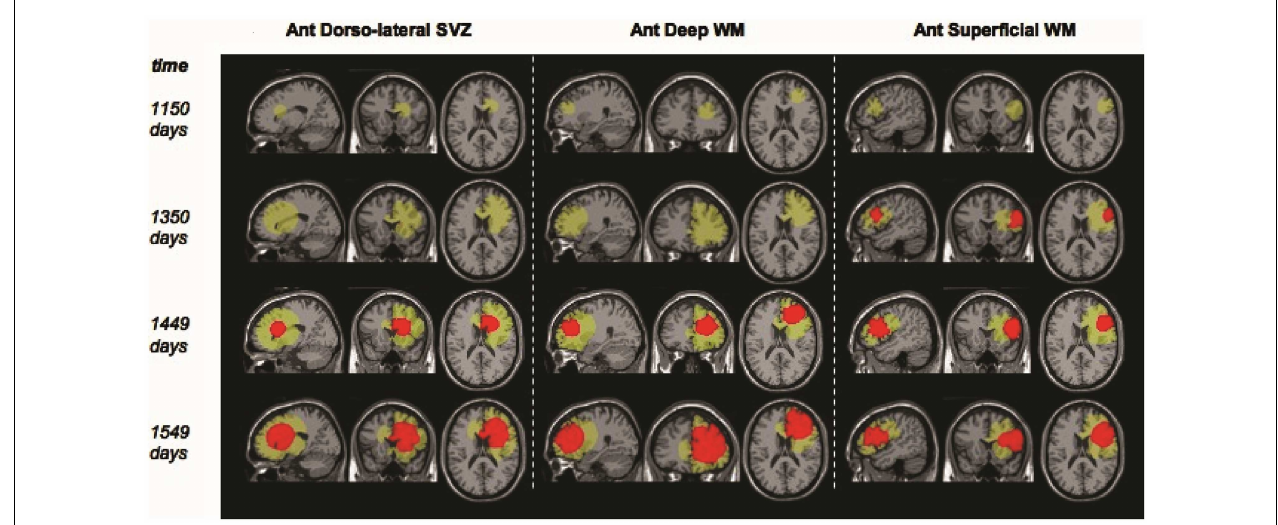
deep white matter, and anterior superficial white matter. Green area reflects estimatedT2-weighted image abnormality on magnetic resonance; red area reflects estimatedT1-weighted image post-gadolinium abnormality.” Courtesy: Bohman et al. (2010).